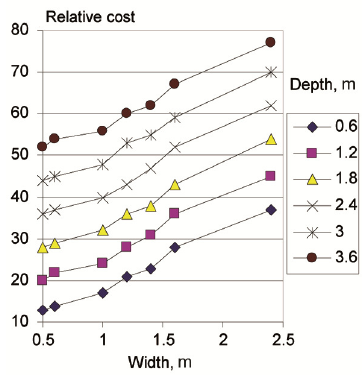
Fig. 4. Strip foundation work force (enlarged assembled) Fig. 5. Strip foundation relative cost (enlarged